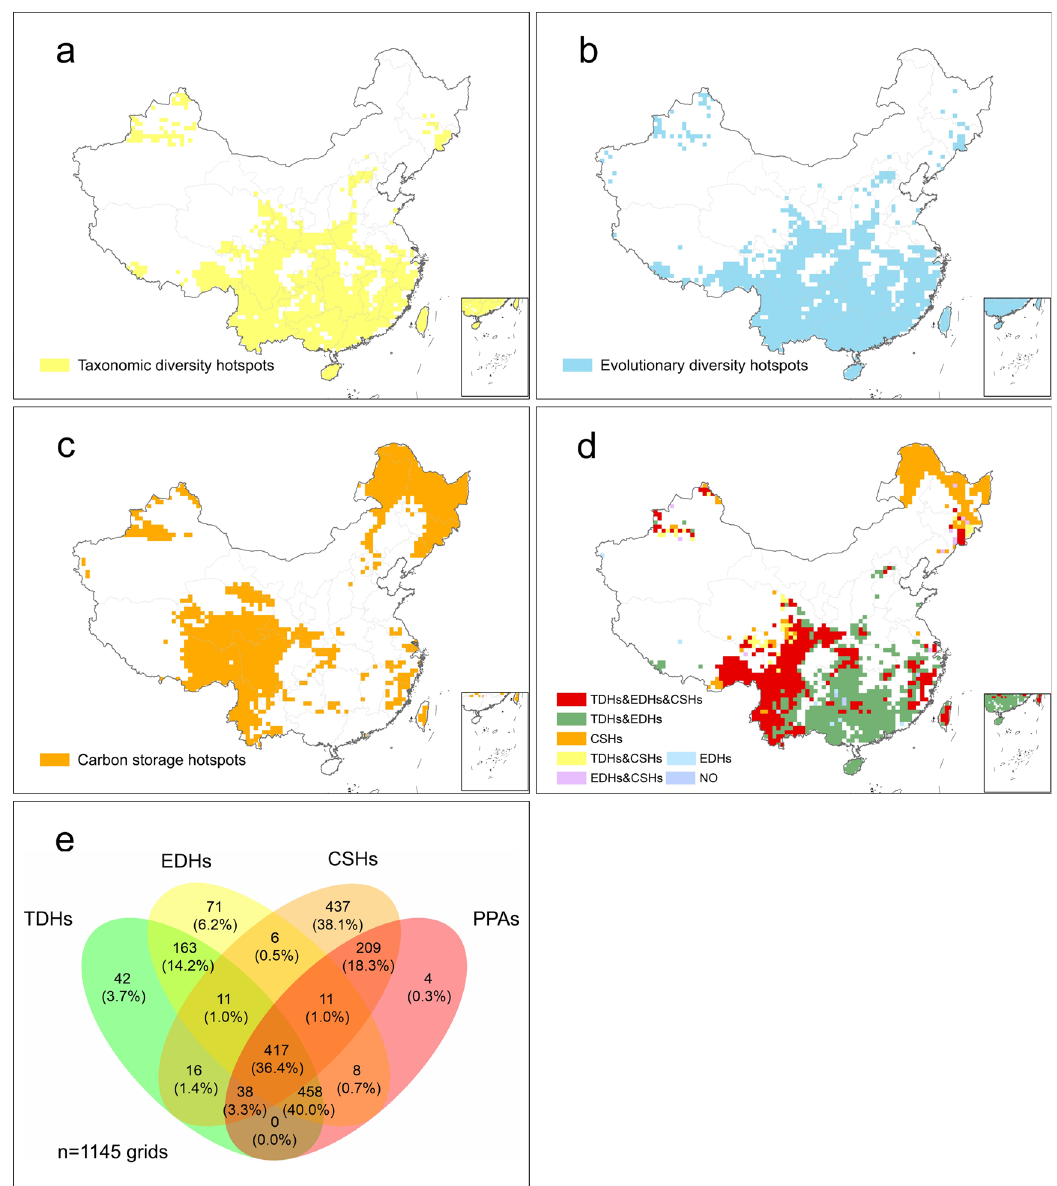
Figure 2. Hotspots map of taxonomic diversity ( a ), evolutionary diversity (i.e., evolutionary history- related indices) ( b ) and carbon storage ( c ). Hotspots were set as the highest value 30% of the area, ( d ) Overlapping map of taxonomic diversity hotspots (TDHs), evolutionary diversity hotspots (EDHs) and carbon storage hotspots (CSHs) in PPAs. For instance, TDHs & EDHs & CSHs means PPAs overlapped with TDHs, EDHs and CSHs, NO means PPAs did not overlap with any hotspot, ( e ) the number and percentage of grids where PPAs overlapped with TDHs, EDHs and CSHs ( n = 1145 grids).